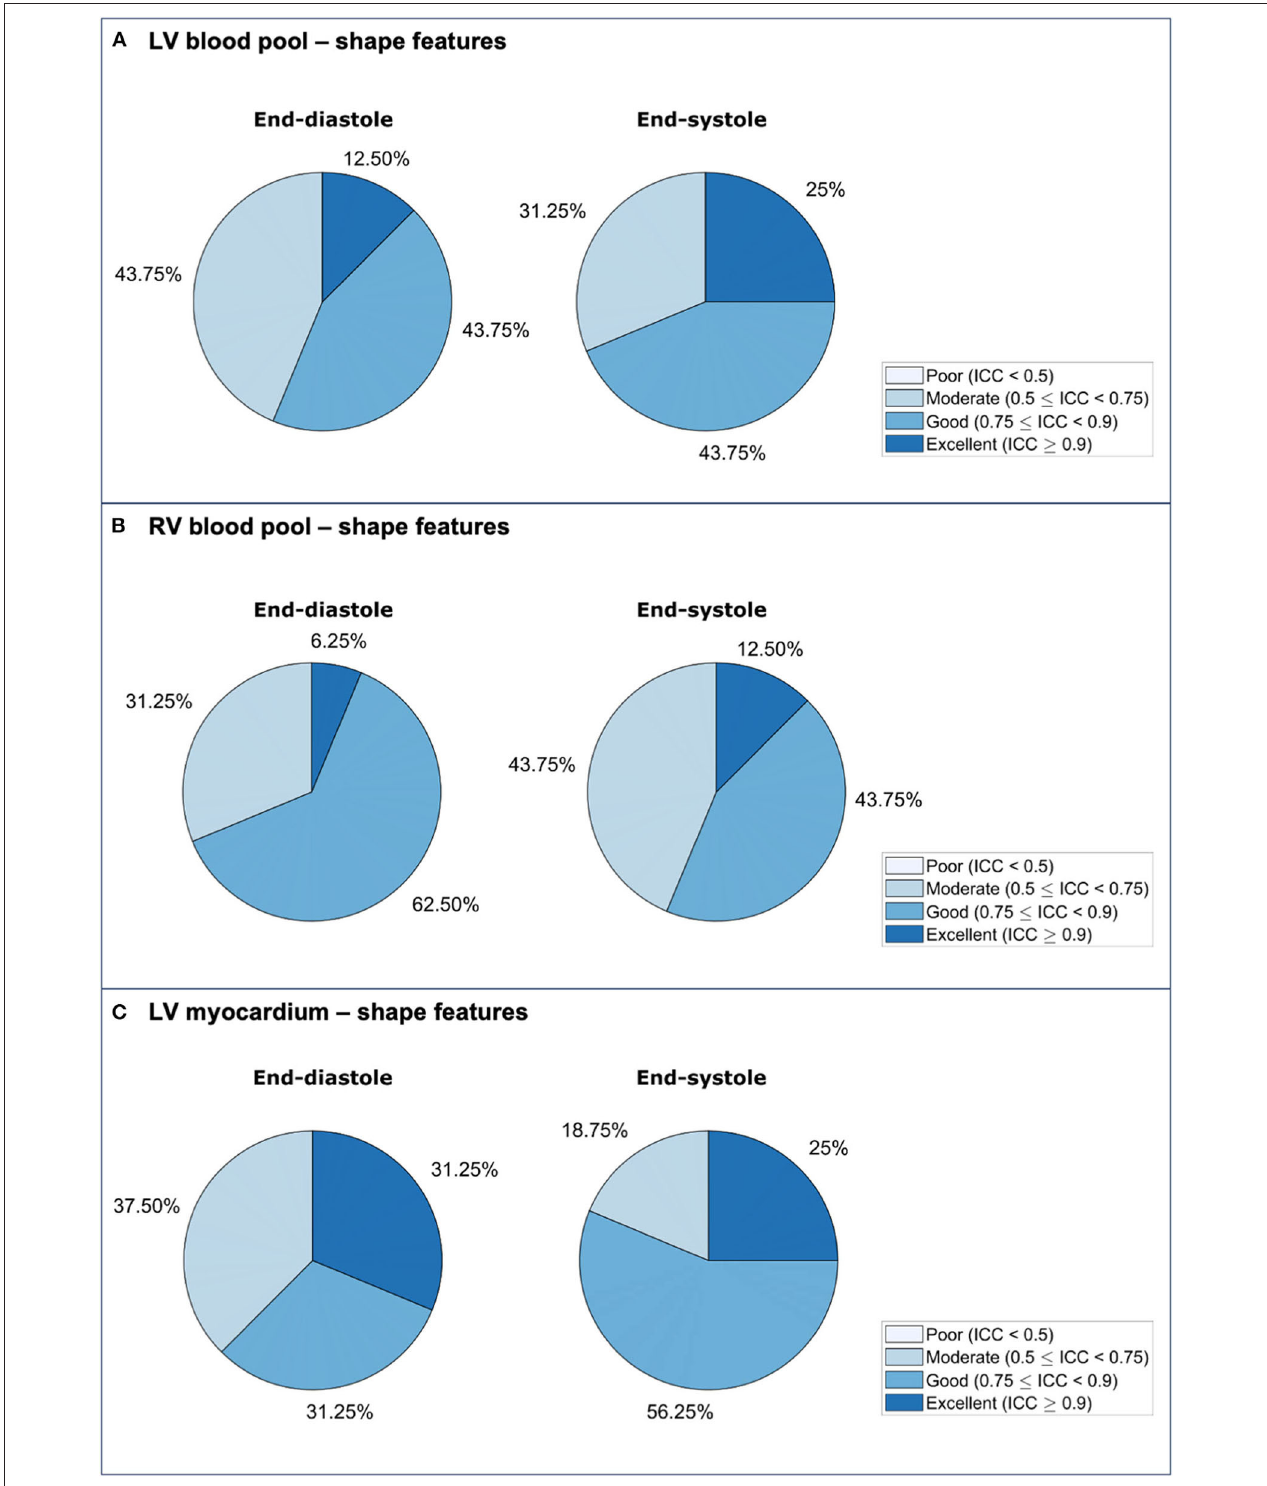
FIGURE 3 | Repeatability of radiomics shape features for the LV blood pool (A) , RV blood pool (B) , and LV myocardium (C) in end-diastole and end-systole. ICC: intra-class correlation coefficient; LV: left ventricle; RV: right ventricle.